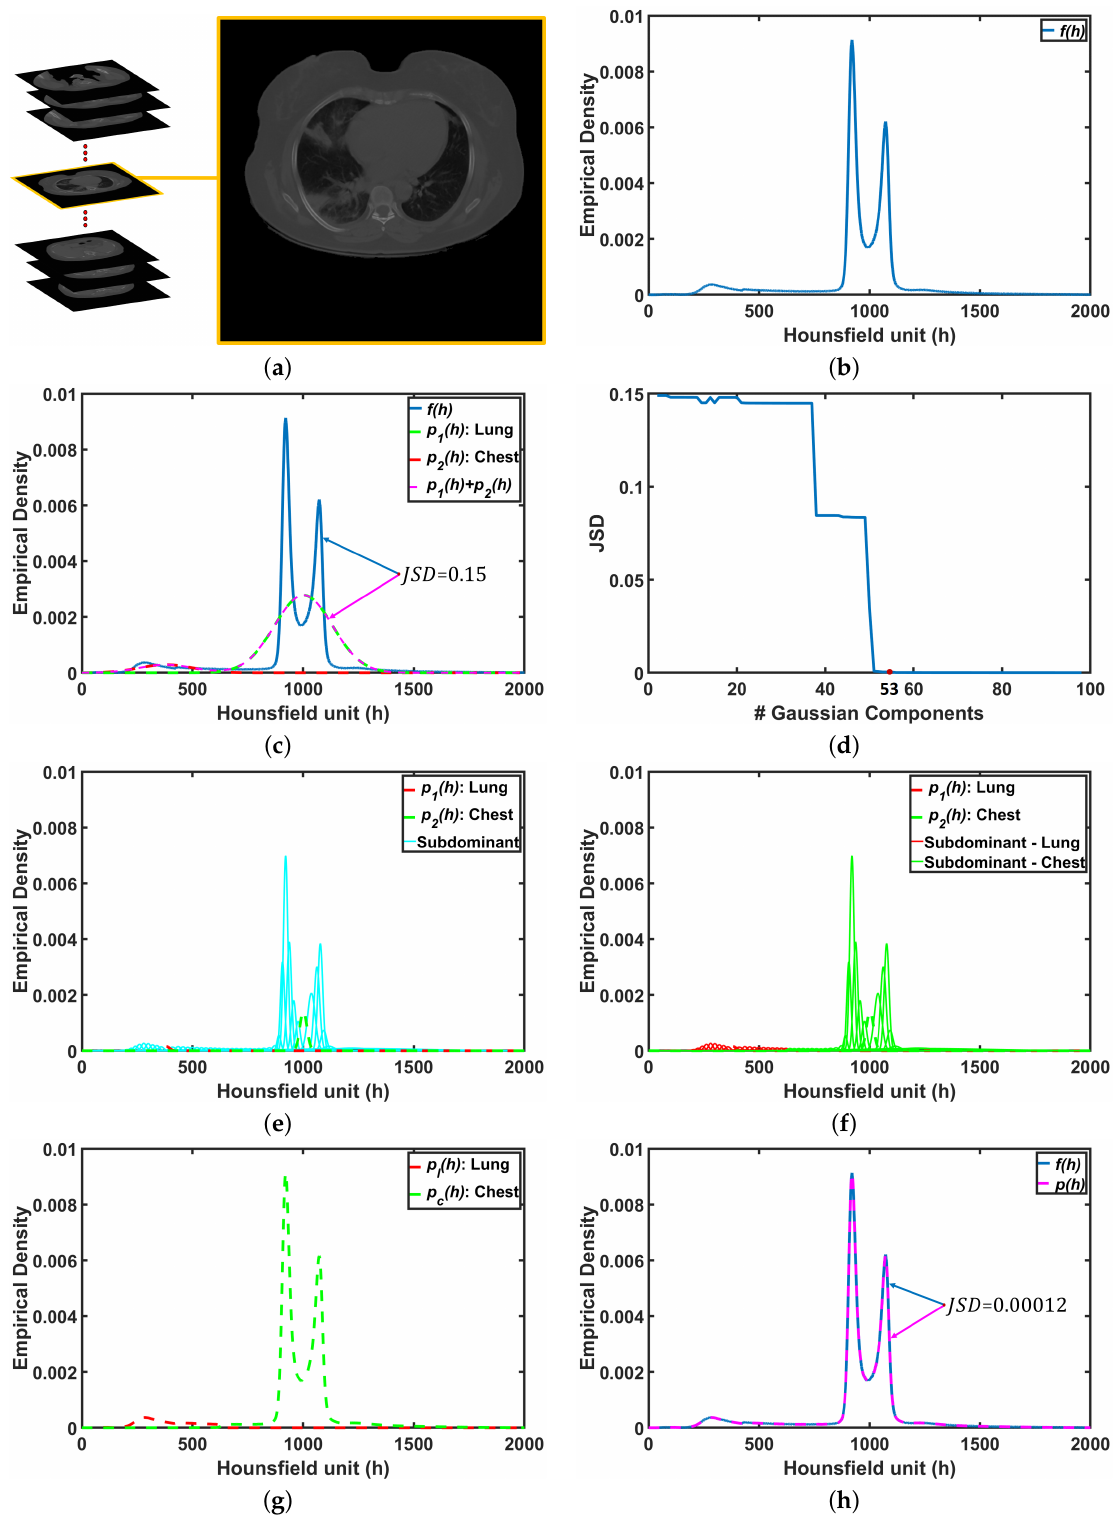
Figure 5. An illustrative example of the proposed system: ( a ) CT chest volume, ( b ) empirical density, ( c ) two dominants Gaussian components, ( d ) JSD between empirical density and mixed density, ( e ) two dominant and K − 2 subdominant Gaussian components, ( f ) proposed cluster algorithm, ( g ) marginal density for lung and chest, and ( h ) final mixed density for all components. Note that JSD stands for Jensen–Shannon